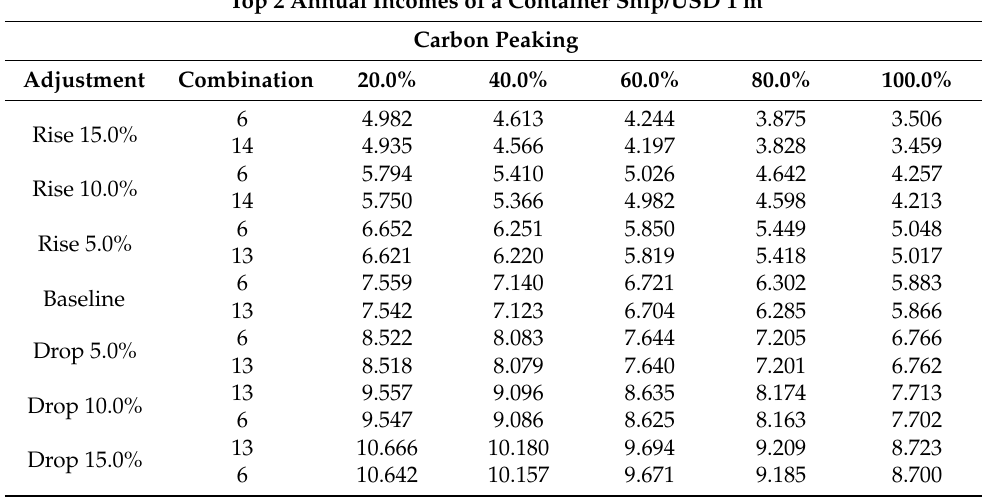
Table 8. Sensitivity analysis of bunker price.